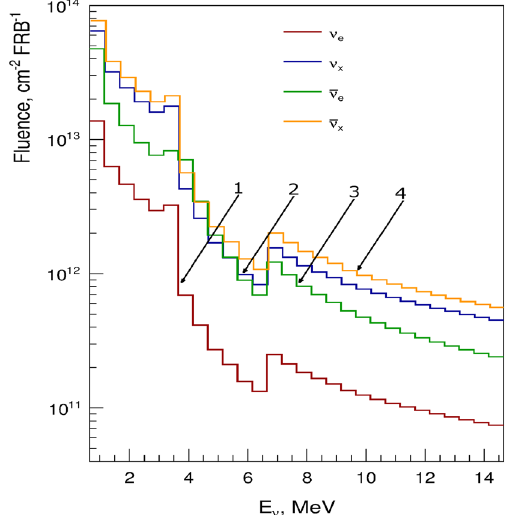
Fig. 3 90% C.L. upper limits on mono-energetic neutrino fluences obtained through the temporal correlation analysis for 42 most inten- sive FRBs with the fluence Φ FRB ≥ 40 Jy ms: 1 – ν e , 2 – ν μ,τ , 3 – ¯ ν e , 4 – ¯ ν μ,τ